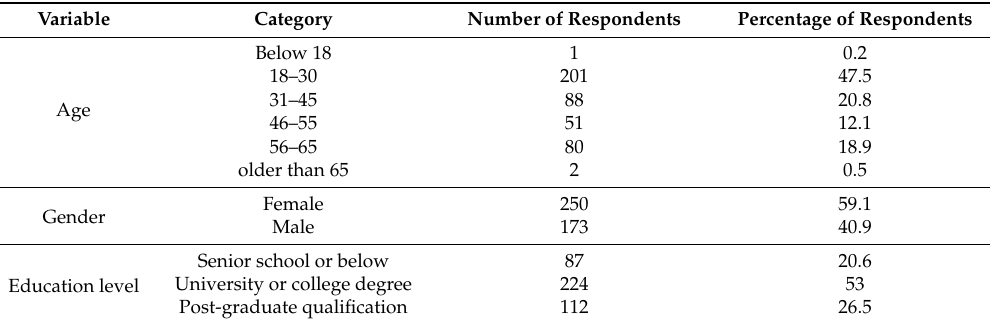
Table 1. Demographic Characteristics of Respondents.